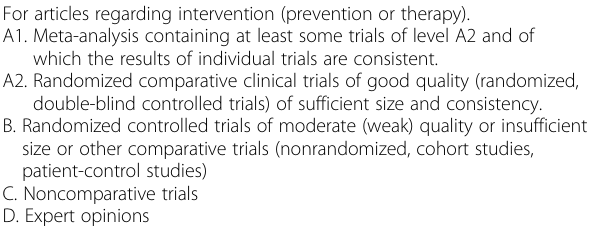
Table 2 Classification of Level of Evidence (Translated from the Dutch classification of